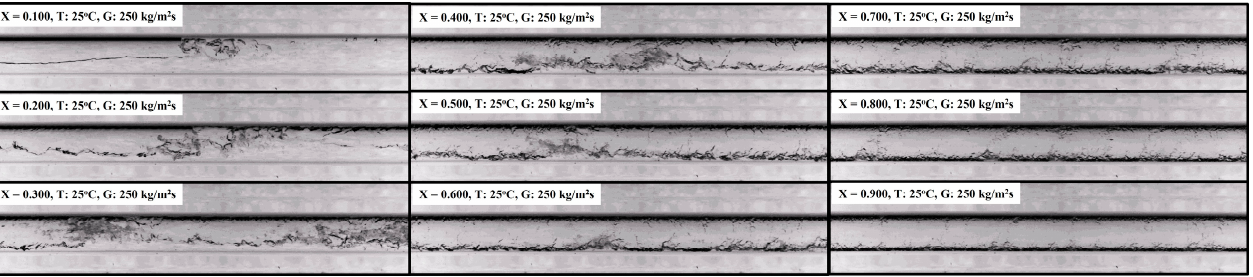
Figure 6. Transition patterns of the R32 flow; 25 °C, 250 kg m − 2 s − 1 ; group 1: the slug to intermittent flow transition, group 2: the intermittent to annular flow transition.